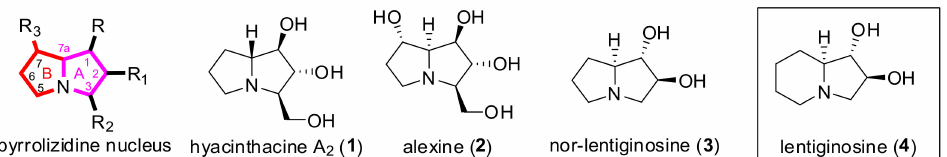
Figure 1. Representative biologically active natural pyrrolizidine alkaloids and analogues of in- dolizidine